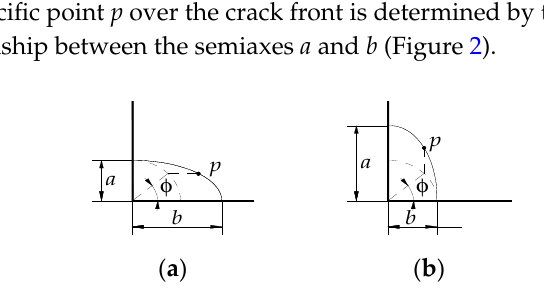
Table 1. Applicability ranges for the equations by Newman and Raju